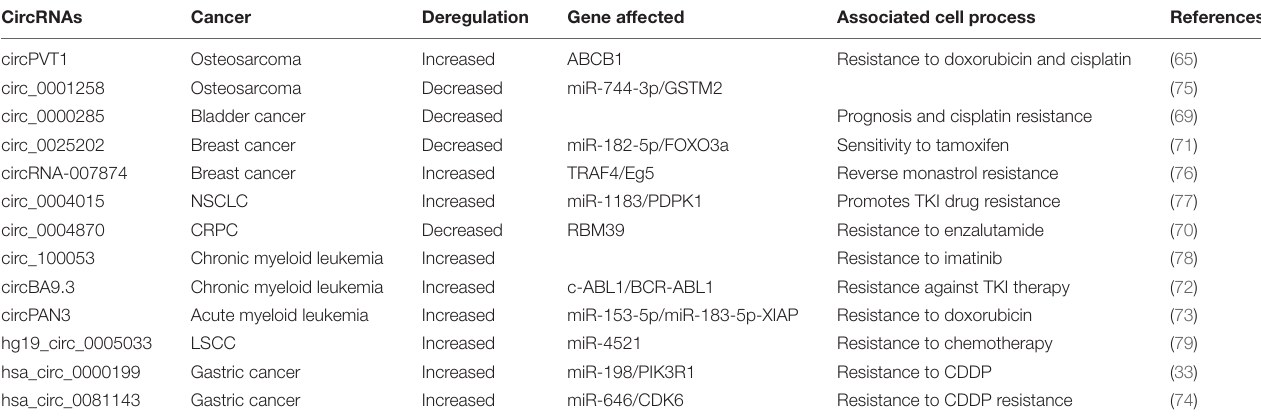
TABLE 2 | CircRNA in cancer therapy